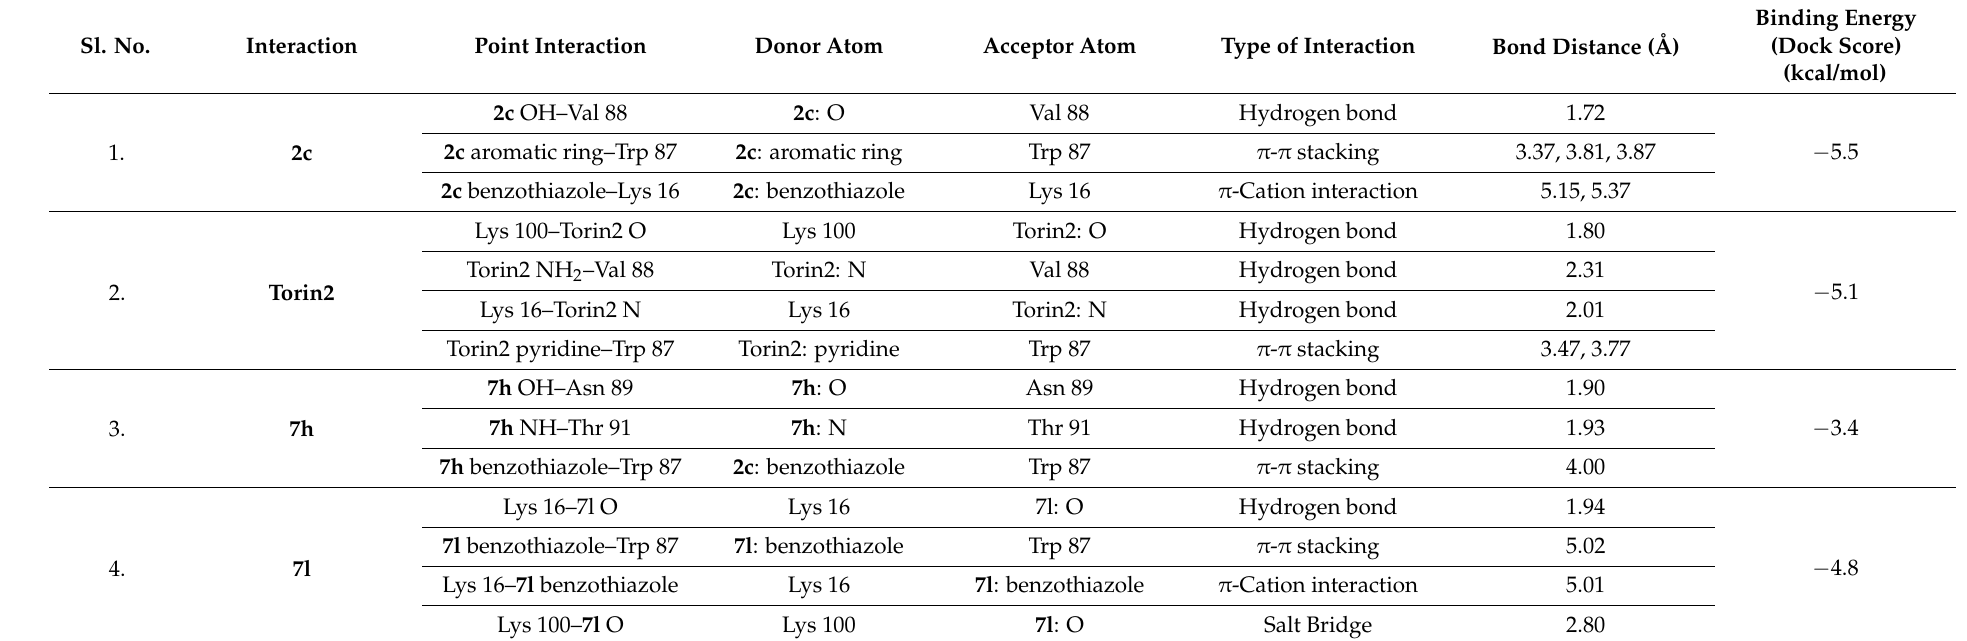
Table 2. Molecular docking results for Torin2 and compounds 2c , 7h and 7l